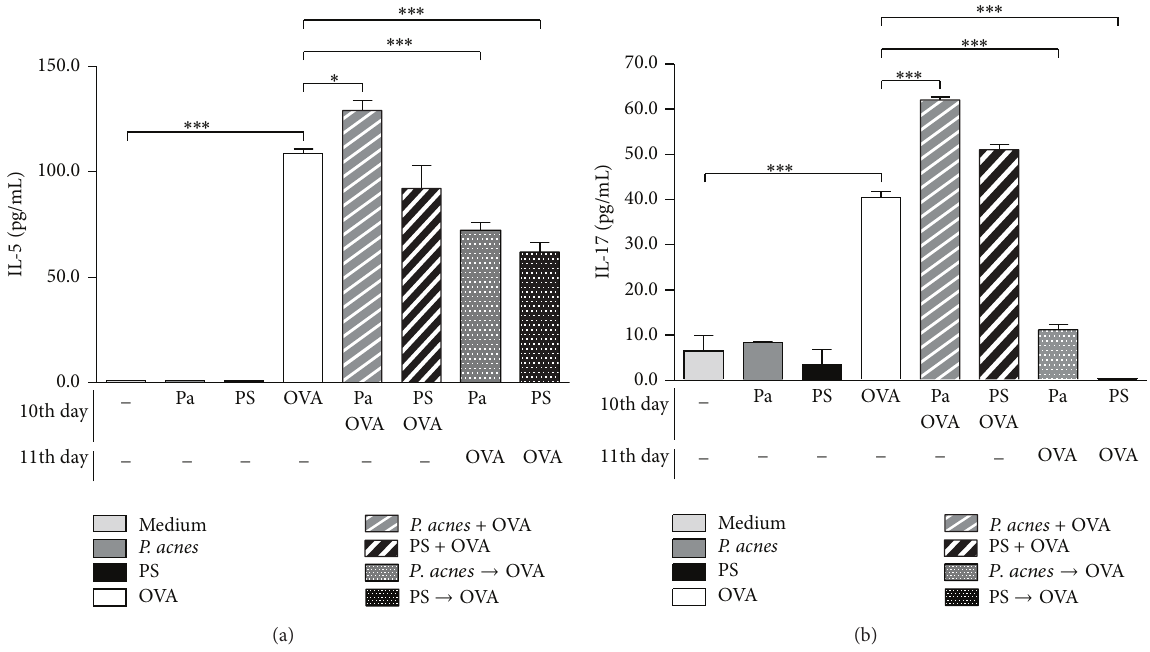
Figure 6: Cytokines production in cocultures of bone marrow-derived dendritic cells and OVA-primed T lymphocytes. Bone marrow cells from na¨ıve F1 BALB/c x A/J mice were cultured during 10 days with GM-CSF, for dendritic cell differentiation. At 10th day, enriched OVA- primed T lymphocytes, obtained from the spleen of HEW-implanted F1 BALB/c x A/J mice, were added to the cultures. The following in vitro stimuli were performed: P. acnes , PS, or OVA at 10th day; P. acnes or PS, concomitantly to OVA, at 10th day ( P. acnes + OVA and PS + OVA, resp.); P. acnes or PS at 10th day and OVA at 11th day ( P. acnes → OVA and PS → OVA, resp.). Supernatants were collected at 12th day